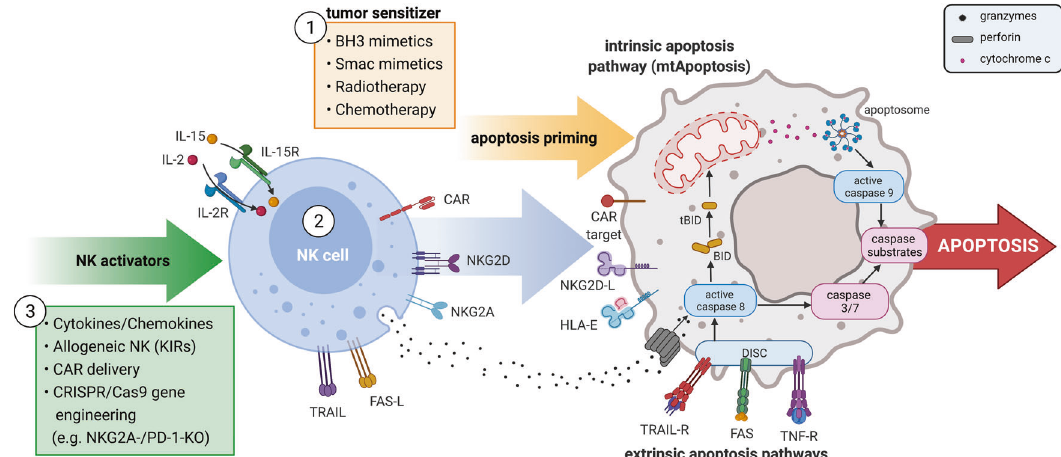
Fig. 1 Multi-step scenario of apoptosis-induction in cancer cells. Examples for ef fi cient immune-oncology approaches combining ① tumor sensitizing agents, ② NK cell therapy and ③ NK cell activating strategies. This fi gure has been created with